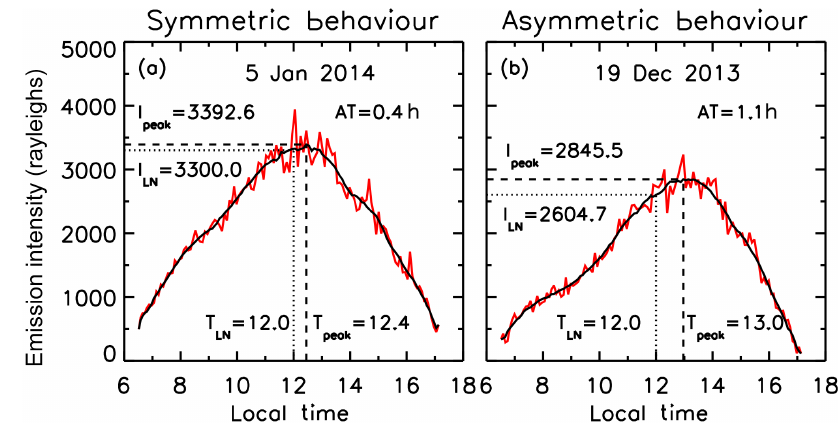
Figure 2. Sample of the diurnal behaviour of OI 630.0nm dayglow emissions. (a) Symmetric diurnal behaviour in intensities with respect to local noon. The behaviour shows solar zenith-angle-dependent variation. Note that with respect to noon the rise and fall in intensities seem symmetric. (b) Asymmetric diurnal behaviour in intensities with respect to local noon. The peak in intensities is achieved after about 1h from noon. Note the rise in intensities is more gradual than the decrease. The product of ratio of intensities at the peak to those at noon and the difference in times between the peak reached and local noon yield the value of asymmetricity in time (AT), which is also shown in both the panels.